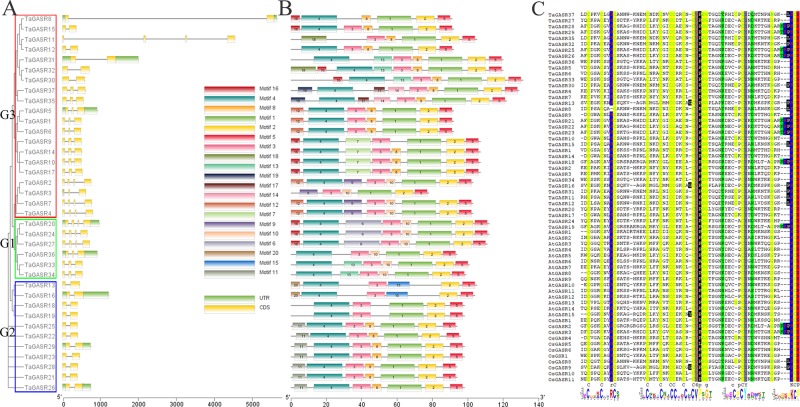
Evolutionary and gene structure analysis of TaGASR genes. (A) Phylogenetic relationships and gene structures of TaGASR genes. Exons, introns and untranslated regions (UTRs) are indicated by yellow rectangles, gray lines, and green rectangles, respectively. Colored boxes indicate the subfamily based on the phylogenetic analysis. (B) Schematic representation of 20 conserved motifs in TaGASR genes. Conserved motifs in TaGASR genes were identified using MEME. Different colored boxes represent different motifs. Box lengths in the figure do not represent actual relative motif sizes. (C) Multiple sequence alignment of TaGASR proteins. Sequences were aligned using DNAMAN software. The GASA motif is clearly highly conserved.